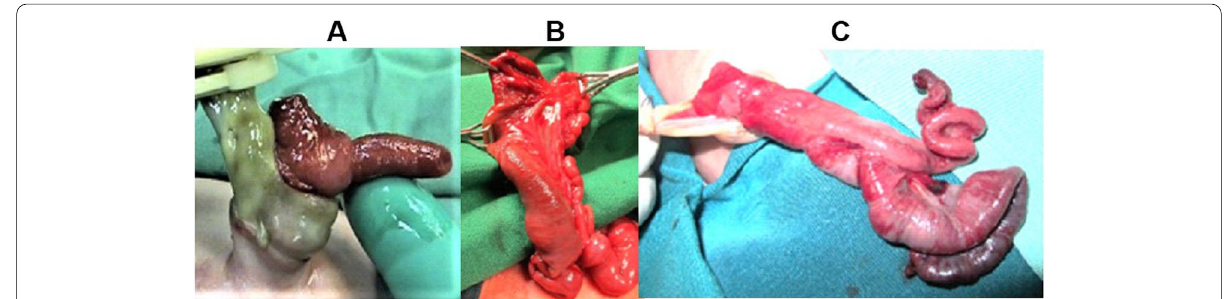
Fig. 4 Hernia of the umbilical cord (HUC) associated with other abnormalities: A HUC with patent vitellointestinal duct (PVID) and ileal atresia treated as the standard surgical excision and repair of PVID; ileal atresia was treated with resection and anastomosis. B HUC with intestinal obstruction due to multiple ileal atresia, and microcolon, ileostomy was created after resection and anastomosis of the ends of atretic segments. C Rupture of HUC exploration under general anesthesia with finding of bowel non-rotation, short bowel, and ileocecal perforation, treated with repair of the perforation and colostomy